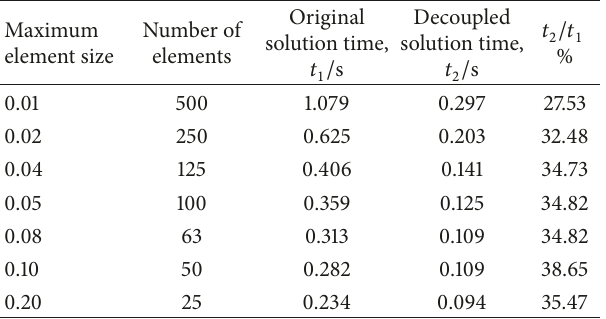
Table 4: Comparison of solution time in 1D model using direct solver, UMFPACK.